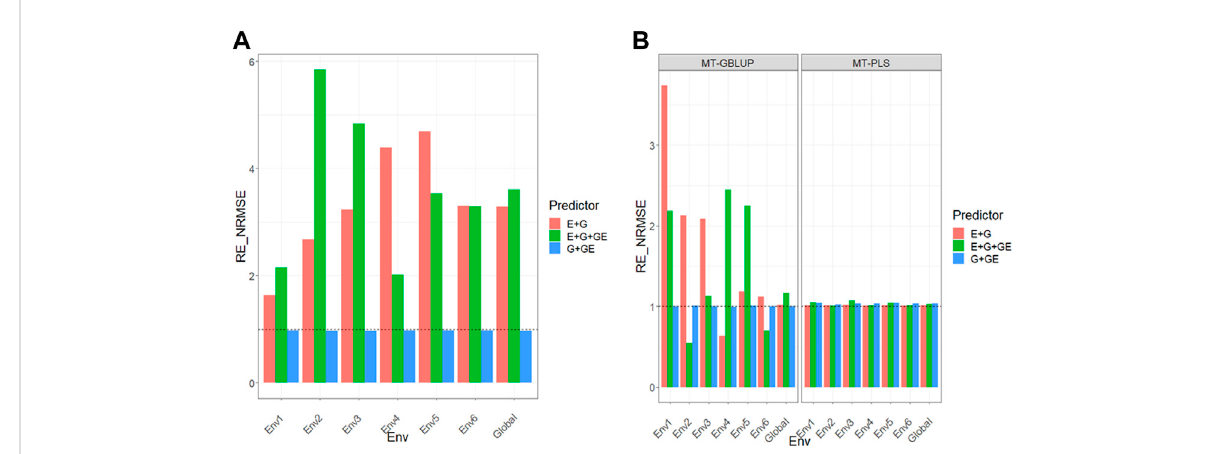
FIGURE 3 (A) Relative ef fi ciency in terms of normalized root mean square error (RE_NRMSE) computed by dividing the NRMSE under the multi-trait best linear unbiased predictor model (MT-GBLUP) by the NRMSE of the multi-trait partial least square regression method (MT-PLS). Prediction performanceisreportedacrosstraitsforeachenvironmentandacrossenvironments(Global)indataset3(Disease),alsowiththreepredictors(E+G, E + G + GE and G + GE). When the RE_NRMSE > 1 the MT-PLS outperform in terms of prediction performance (lower NRMSE) the MT-GBLUP method. (B) Relative ef fi ciency in terms of normalized root mean square error (RE_NRMSE) computed by dividing the NRMSE of either the UT best linear unbiased predictor model (UT-GBLUP) or UT partial least square regression method (UT-PLS), by the NRMSE of either MT-GBLUP or MT-PLS method. Prediction performance is reported across traits for each environment and across environments (Global) in dataset 3 (Disease), also with three predictors (E + G, E + G + GE and G + GE). When the RE_NRMSE > 1 the multi-trait method outperform in terms of prediction performance (lower NRMSE) the UT method.